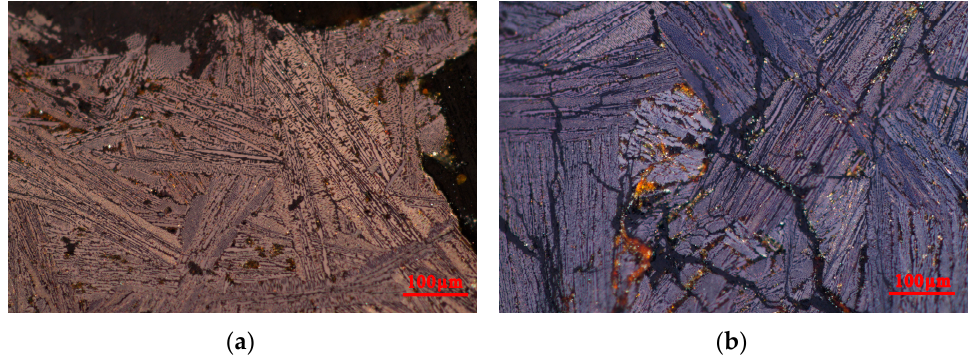
Figure 3. Metallograph of the iron pot of the “Nanhai I” shipwreck. ( a ) Brightfield with polariscope. ( b ) Brightfield with